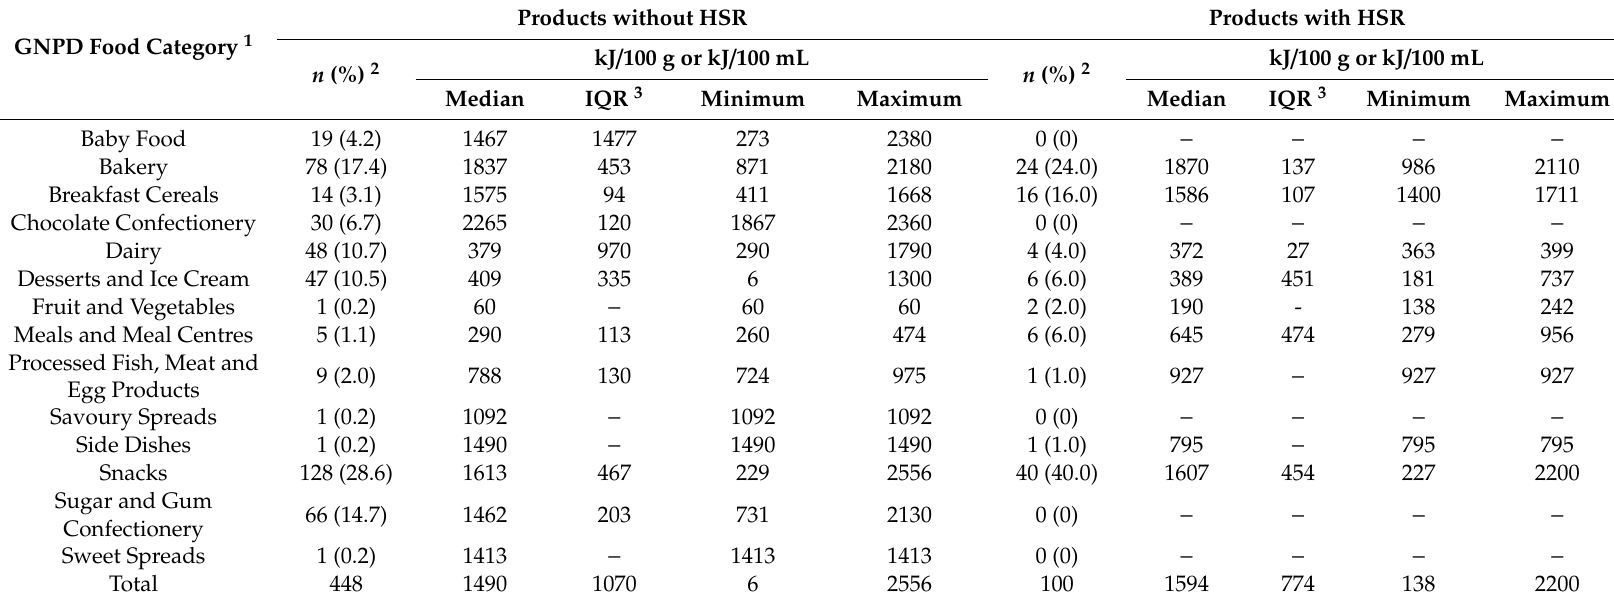
Table 2. The energy density of products without a Health Star Rating (HSR) and with an HSR by Global New Products Database (GNPD) food category.